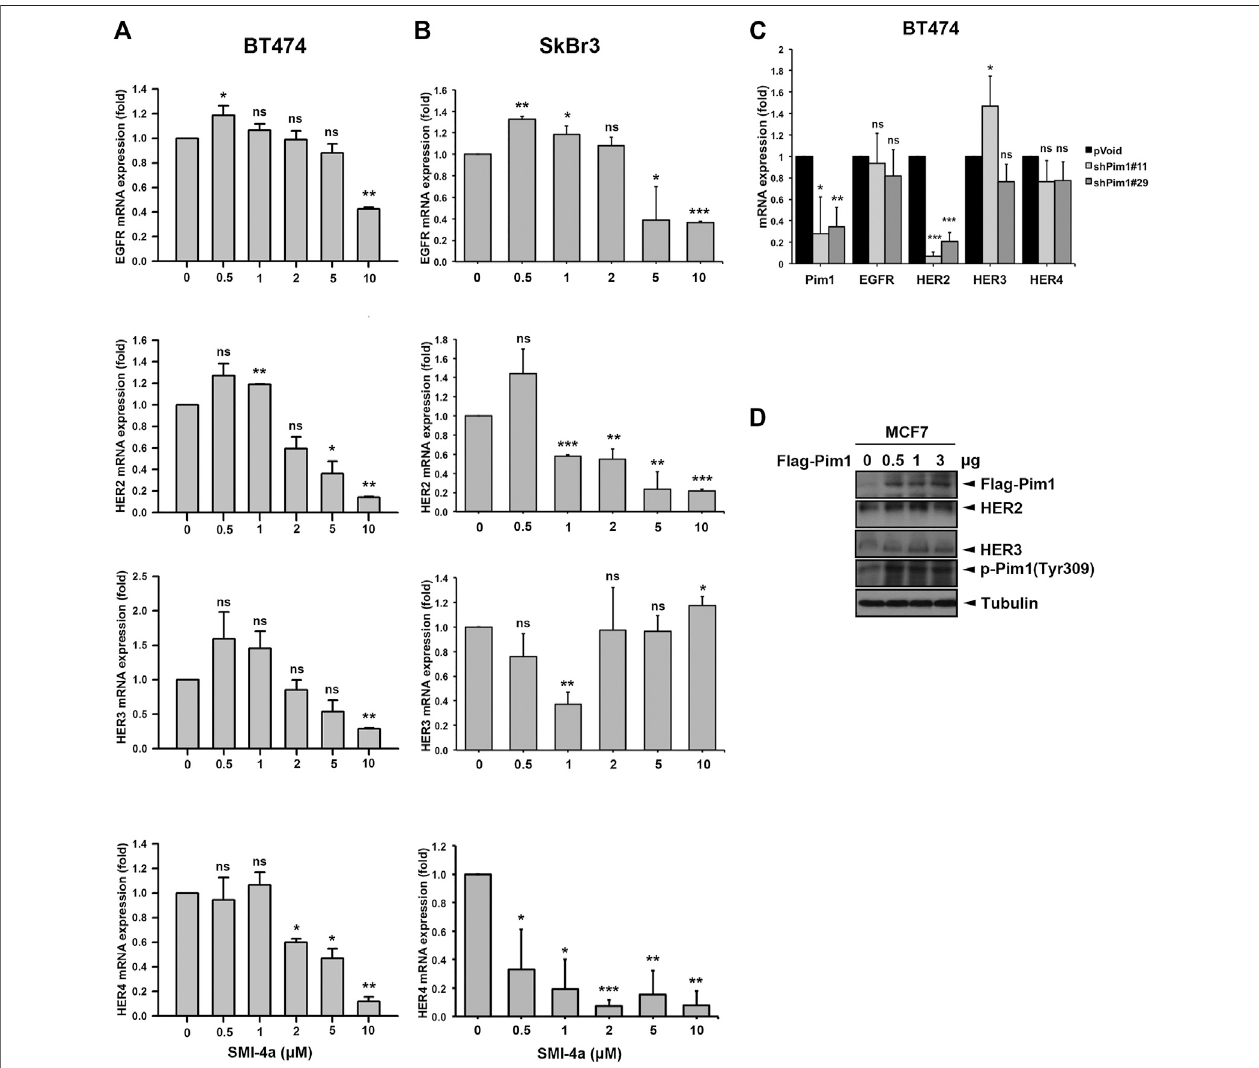
FIGURE6| Pim1transcriptionallyupregulatedHER2expressioninbreastcancercells. (A,B) BT474 (A) andSkBr3 (B) cellsweretreatedwithSMI-4aat0,0.5,1,2, 5, 10 μ M and total RNAs were extracted. The mRNA expressions of the HER family were examined by RT-qPCR followed by normalization with actin expression. (C) BT474 cells were infected with shPim1#11 or shPim1#18 lentivirus for 2 days followed by total RNA extraction. The mRNA expressions of Pim1 and HER family were examined by RT-qPCR followed by normalization with actin expression. (D) MCF7 cells were transiently transfected with the indicated concentration of Flag-Pim1 expression vector for 3 days followed by preparation of total lysates. Protein expressions were examined by western blot using the indicated antibodies. Results were expressed as mean ± S.E.M. of three independent experiments. *: p < 0.05; **: p < 0.01 as compared with control group.